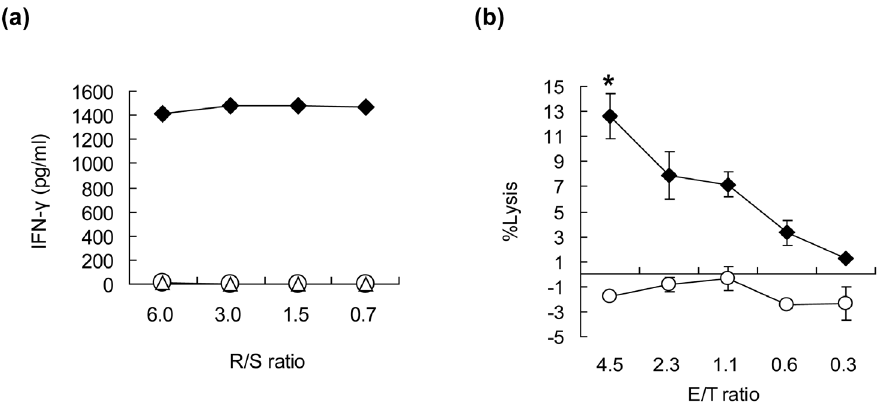
Figure 4. The recognition of HIG2 and HLA-A*02:01-expressing cells by a HIG2-9-4 peptide-specific CTL clone. (a) A HIG2-9-4 peptide- specific CTL clone was stimulated with COS7 cells expressing both HIG2 and HLA-A*02:01 (close diamond), or either HIG2 alone (open circle) or HLA- A*02:01 alone (open triangle), then the IFN- c production was examined by ELISA. R/S ratio; responder/stimulator ratio. (b) The cytotoxic activity of the HIG2-9-4 peptide-specific CTL clone was examined against HLA-A*02:01-positive HIG2-expressing A498 cells (closed diamond) or HLA-A*02:01- negative HIG2-expressing Caki-1 cells (open circle). E/T ratio; effector/target ratio. All experiments were performed in triplicate. Representative results from three independent experiments are shown. *; P , 0.001.